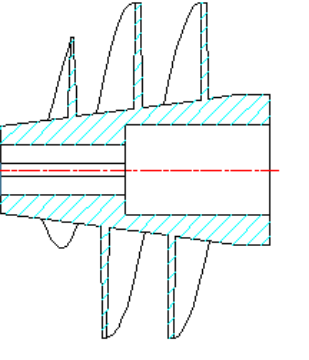
Figure 1. Structure of the inducer. Table 1. Design parameters of the inducer.